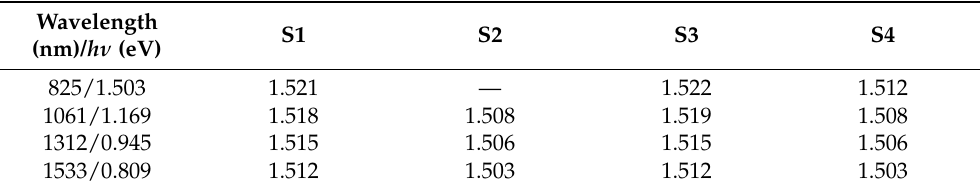
Table 7. Refractive indices of the samples under study measured at different wavelengths in the NIR